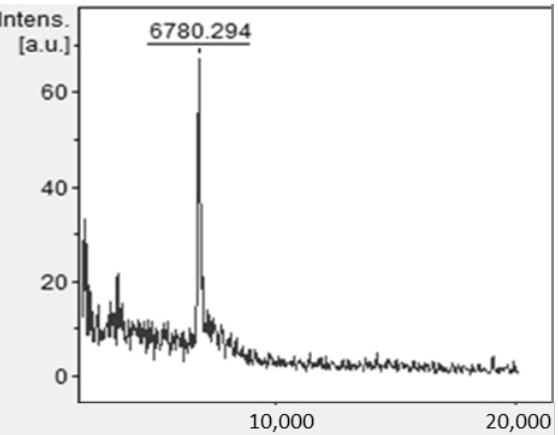
Figure 4. MALDI-TOF mass spectrum from recollected fraction corresponding to the signal of in- terest at 10.8 min by HPLC of an adulterated sample. The molecular weight result (Da) identified for a peptide in this fraction is similar to the molecular weight corresponding to cGMP monomer reported by other authors, between 6755 and 6787 Da [15,20].